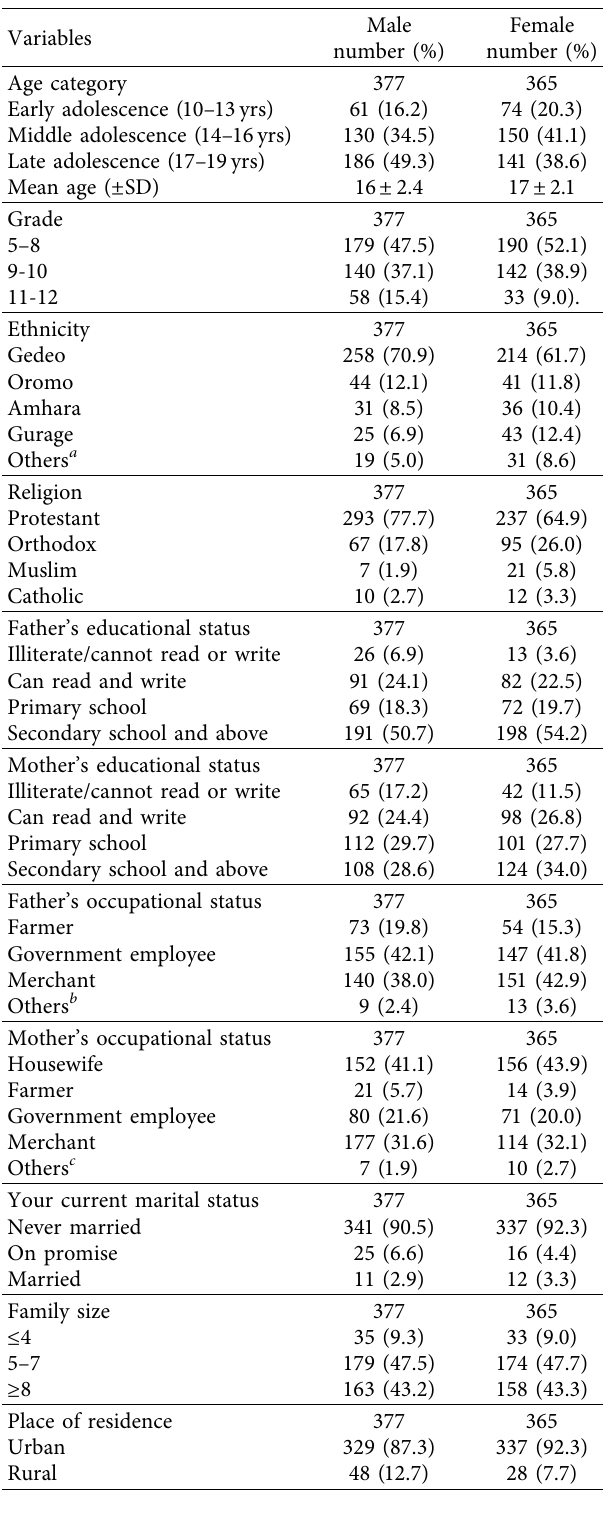
Table 1: Sociodemographic and socioeconomic characteristics of male and female adolescent students in Dilla Town, Gedeo Zone, Southern Ethiopia, May